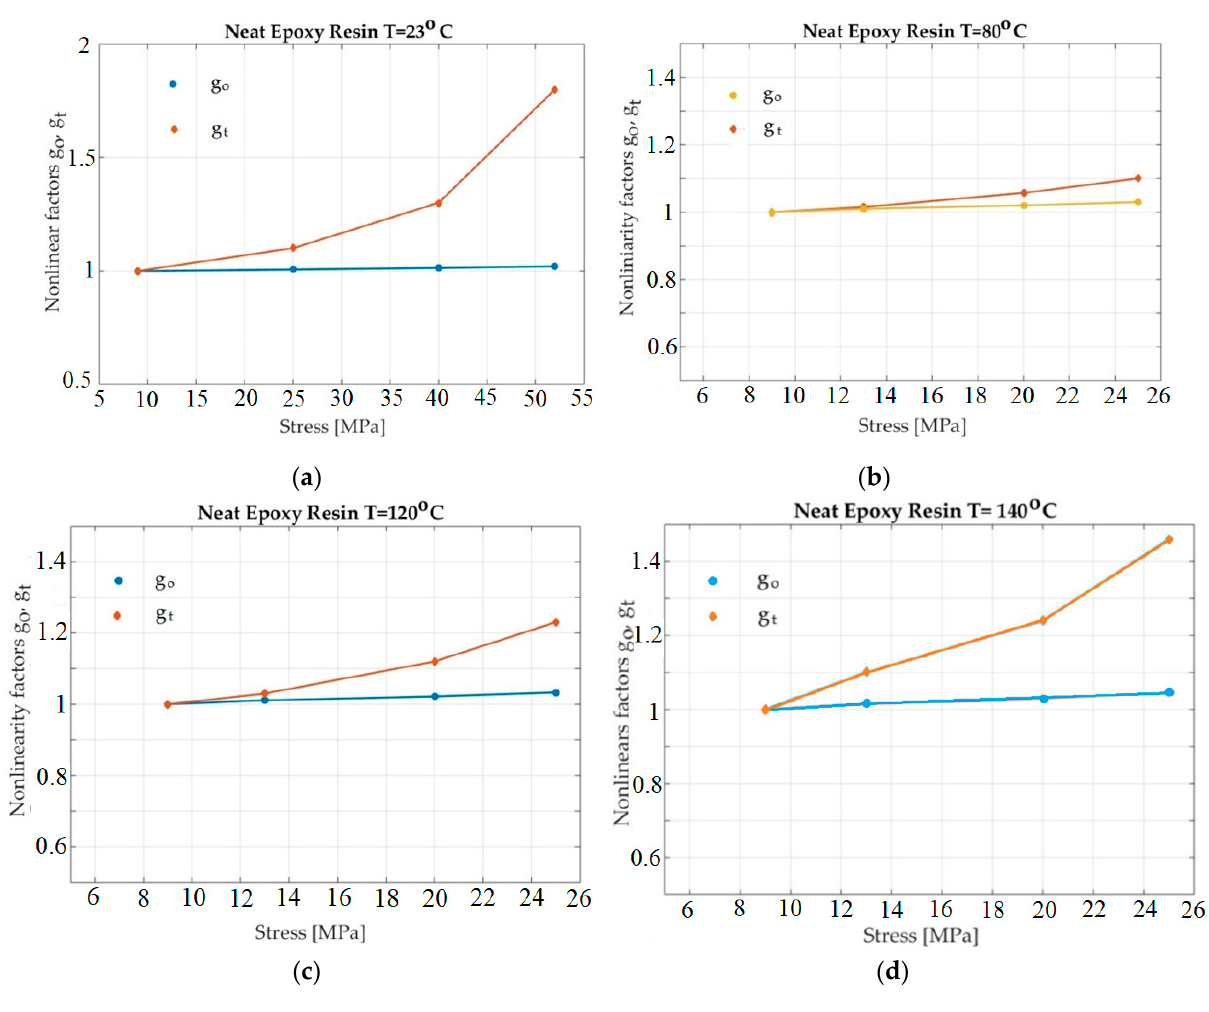
Figure 5. Plot of g o and g t for epoxy resin as a function of stress and temperature. ( a )—T = 23 °C; ( b )—T = 80 °C; ( c )—T = 120 °C; ( d )—T = 140 °C.